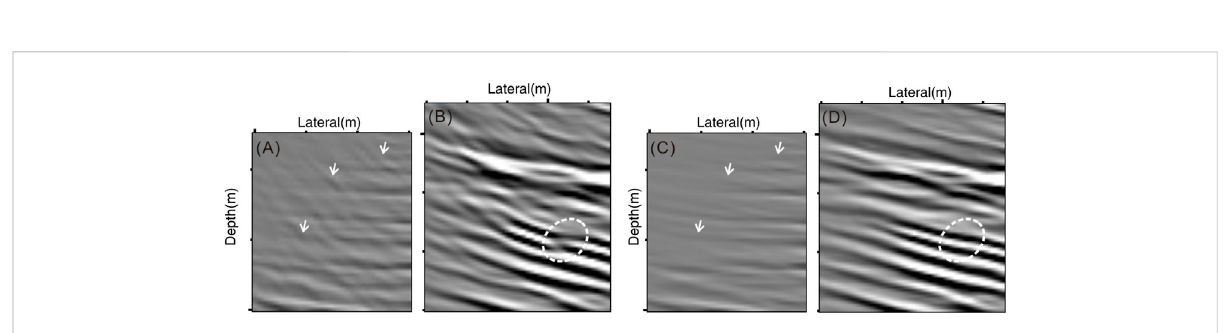
FIGURE 12 Comparison of the enlarged views of corresponding areas marked by white dotted boxes in Figure 11. (A,B) are imaging results of conventional GRT migration; (C,D) are that of weighted DDGRT